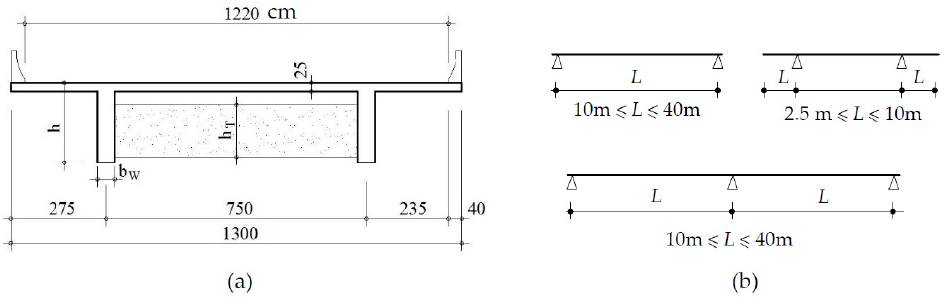
Figure 2. ( a ) RC Π cross section adopted (units: cm) and (b ) structural schemes.